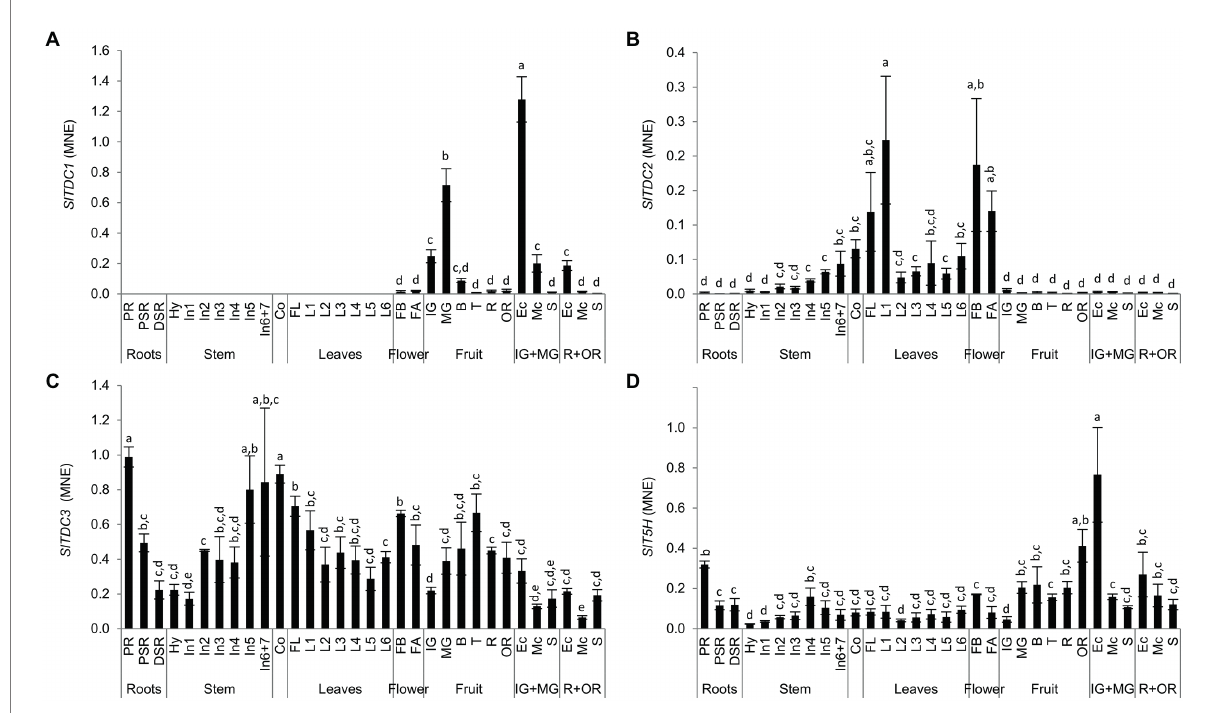
FIGURE 7 Analysis of (A) SlTDC1 , (B) SlTDC2 , (C) SlTDC3 and (D) SlT5H expression in Micro-Tom organs by qRT-PCR. Data are means ± SD ( n = 3). MNE = Mean normalized expression. Different letters on bars indicate that means are significantly different according to post-hoc Tukey-ANOVA ( p < 0.05). The abbreviations and the position of the samples are explained in Figure